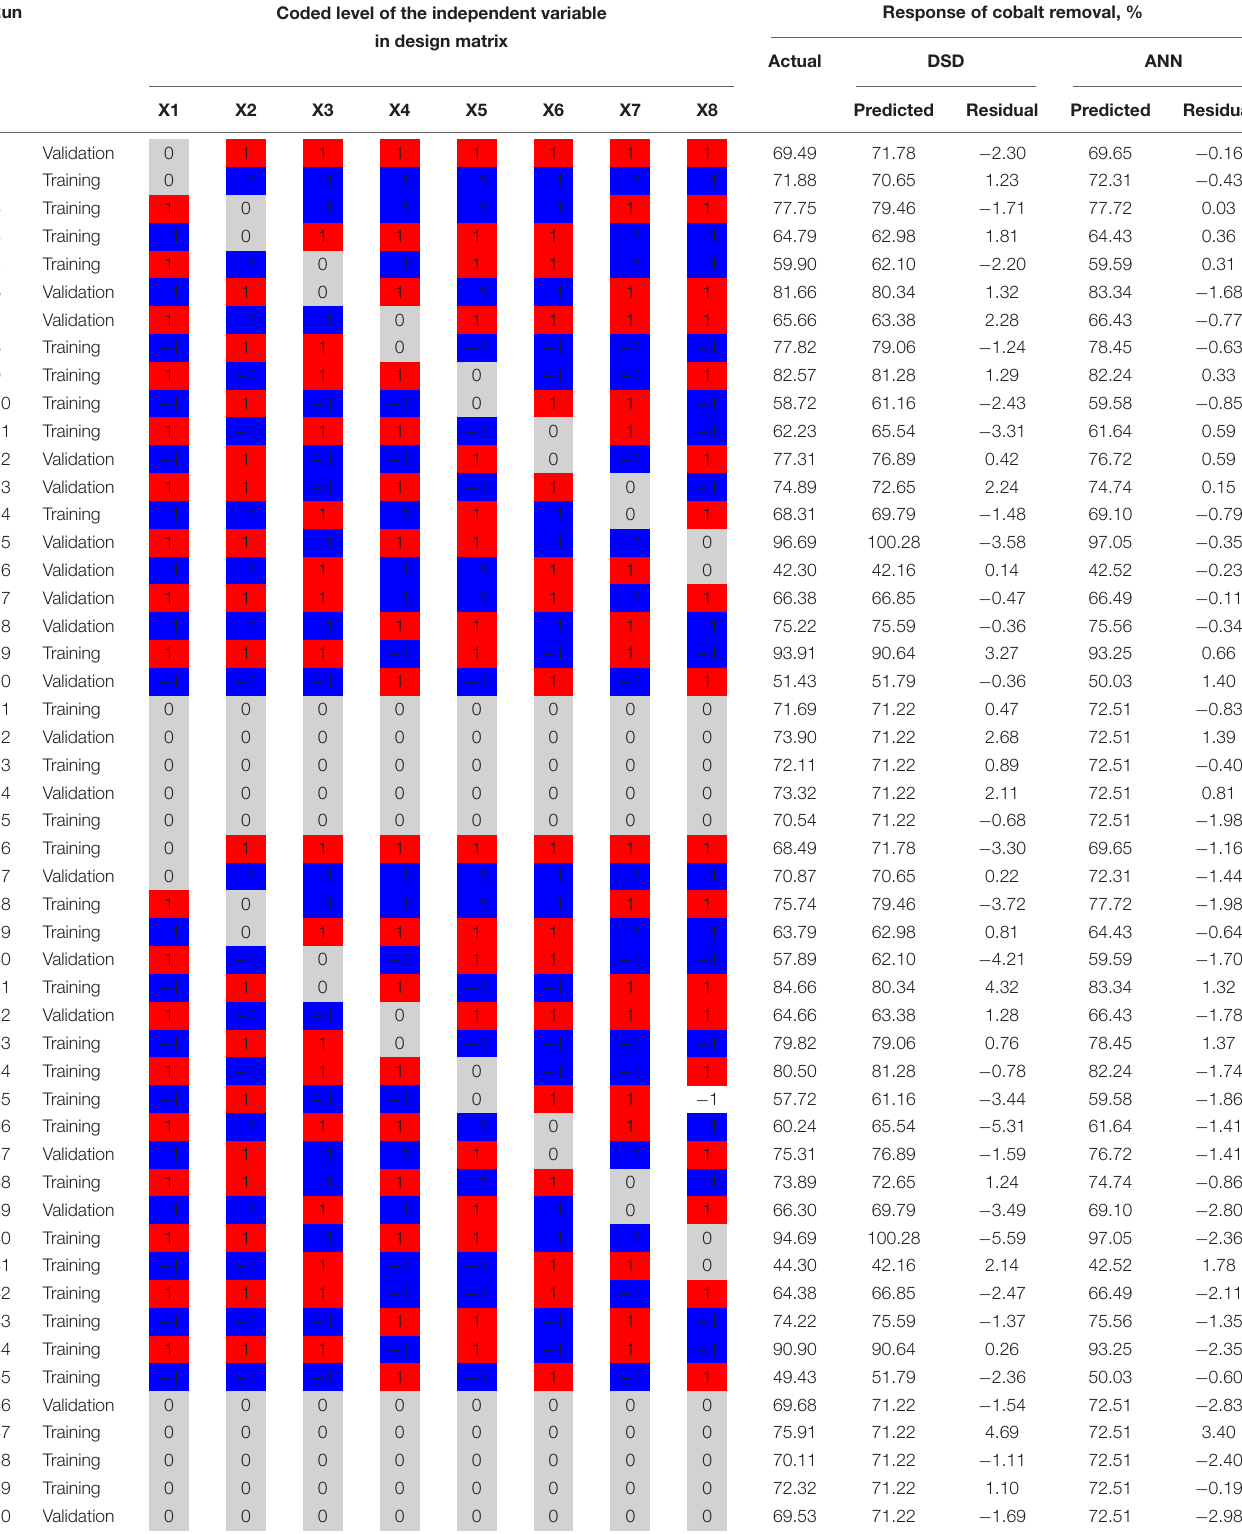
TABLE 1 | The definitive screening design (DSD) matrix of the independent factors, and the experimental data of Co (II) bioremoval by P. alcaliphila NEWG-2 as well as the corresponding predicted and residual values obtained from DSD and artificial neural network (ANN) models. Coded level of the independent variable in design